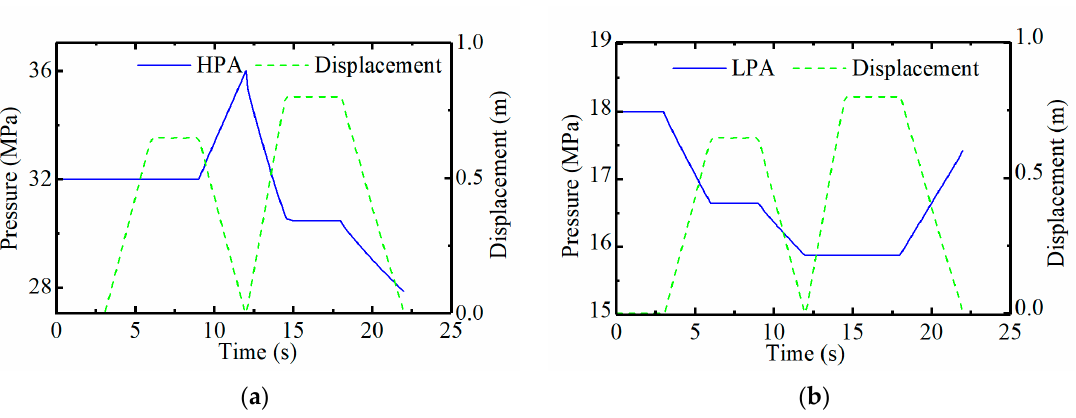
Figure 7. Pressure of accumulators: ( a ) HPA; ( b ) LPA.